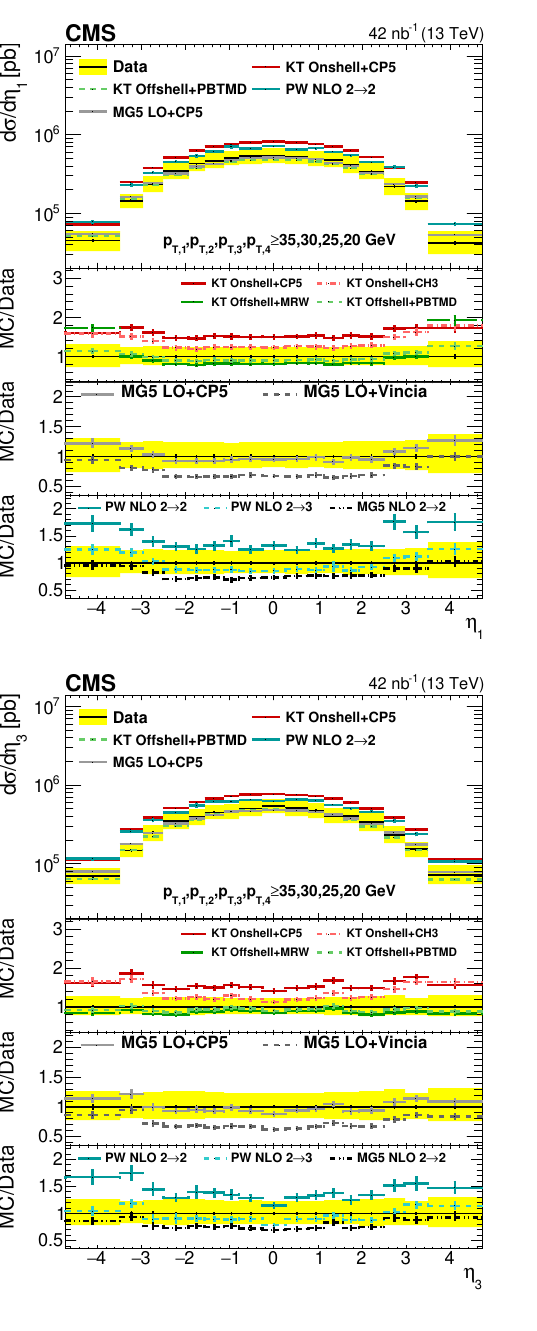
Figure 7 . Comparison of the unfolded η spectra of data with different KaTie (KT), Mad- Graph 5_a mc@nlo (MG5), and powheg (PW) models, for the leading (upper left), subleading (upper right), third leading (lower left), and fourth leading (lower right) jet in Region I. The error bars represent the statistical uncertainty, and the yellow band indicates the total (statisti- cal+systematic) uncertainty in the